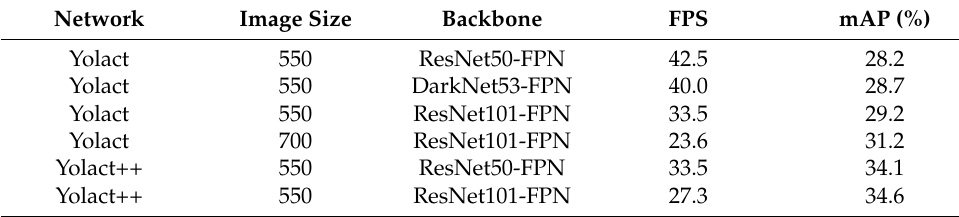
Table 1. Results of different backbone architectures on MS COCO